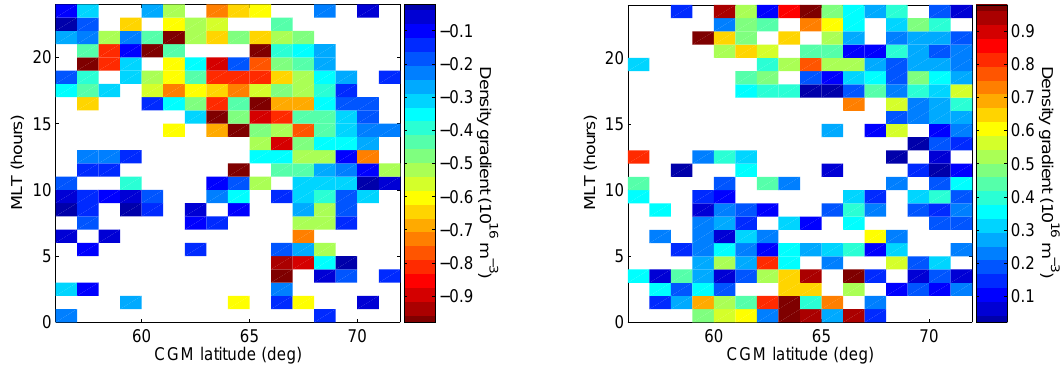
Fig. 5. The mean electron density gradient at the equatorward edge (left) and poleward edge (right) at different geomagnetic latitudes and magnetic local times. The rectangles indicate the location of the edge and the value of the gradient is shown in terms of colour code. 10